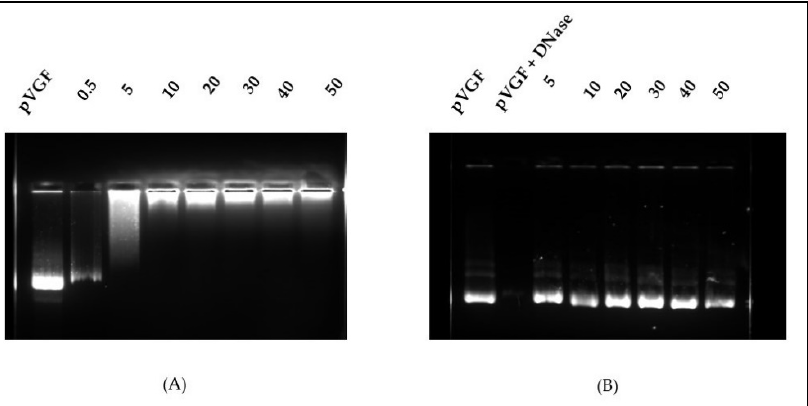
Figure 3. ( A ) Analysis of OA-g-CS-Man-Tat–pVGF complex formation at different weight ratios by agarose gel electrophoresis. ( B ) DNase I protection assay showing protection of DNA from degradation by polymers at the different N/P ratios.